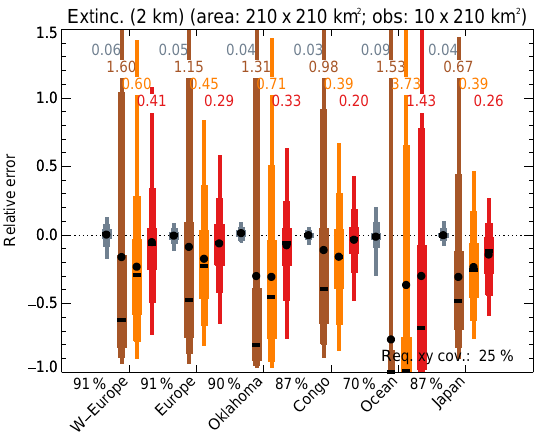
Figure 17. Monthly representation errors for a lidar on a polar- orbiting satellite after collocation: purely spatial sampling (grey), no collocation (brown), area data collocated to the day of obser- vations (bright orange) and area data collocated to the hour (red). Further explanation in Sect. 3.2.